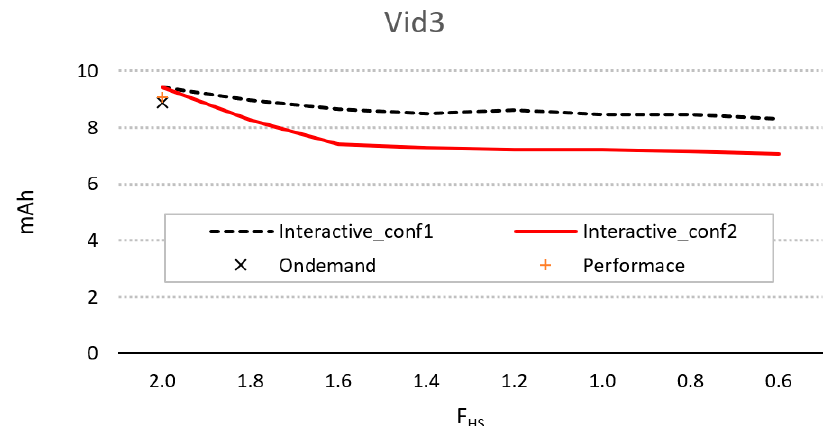
Figure 10. Evolution of energy consumption for the interactive governor for configurations 1 and 2,